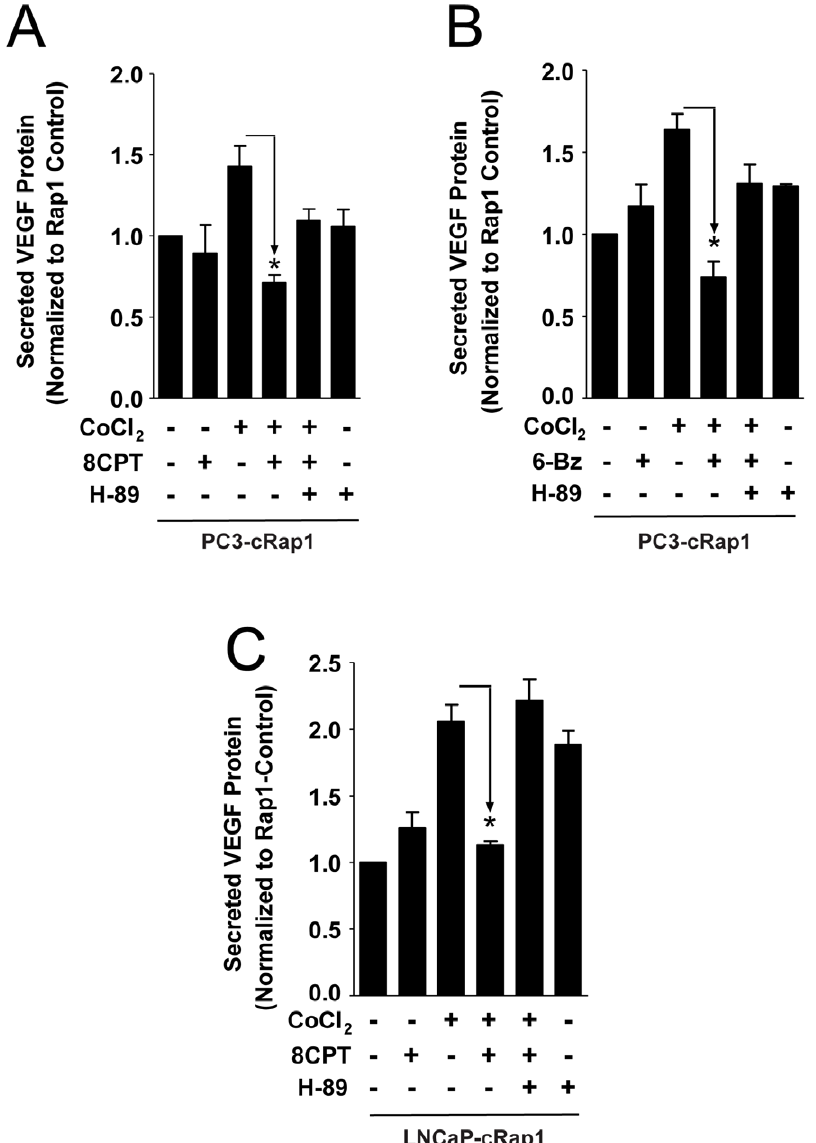
Figure 5. Effect of PKA inhibitor and PKA activator on secreted VEGF in PC3-cRap1 and LNCaP-Rap1 cells under hypoxic-like conditions. Cells were treated as indicated, and VEGF levels were measured by ELISA as described in Methods. (A) Reversal of 8CPT effects by H-89 in PC3-cRap1 cells; *p , 0.05, n=3. (B) Reversal of 6BzcAMP (6Bn) effects by H-89 in PC3-cRap1 cells; *p , 0.05, n=3. (C) Reversal of 8CPT effects by H- 89 in PC3-cRap1cells; *p , 0.05,